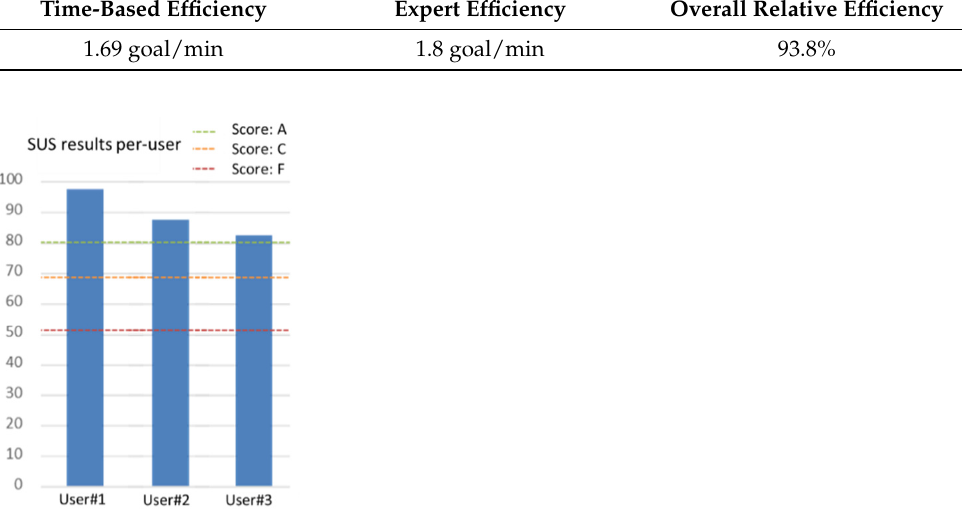
Figure 8. SUS questionnaire results (blue bars) and reference thresholds (lines).